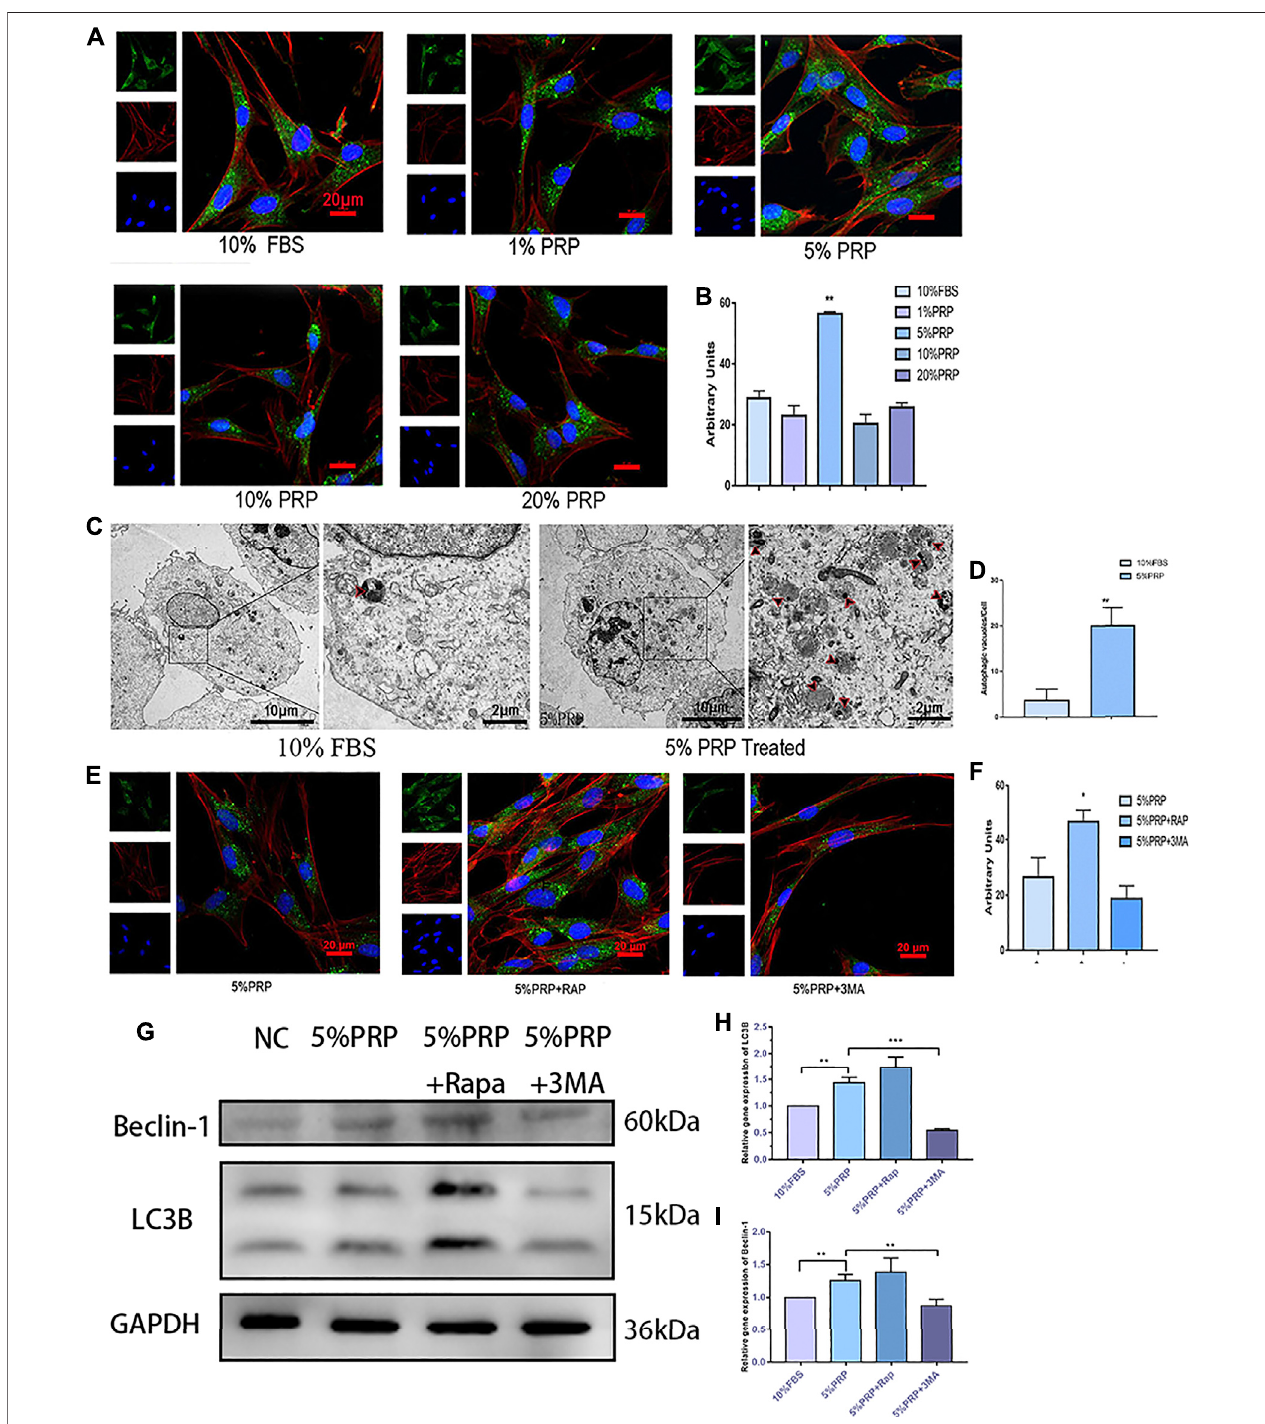
FIGURE 3 | (A) Autophagy activation by PRP. By immuno fl uorescence staining, 5% PRP obviously increased the expression of LC3B (scale bar, 20 μ m). (B) The graph shows the quantitative analysis of LC3B fl uorescence by Image J. (C) By transmission electron microscope, 5% PRP-treated hDPCs showed a large number of autophagic vacuoles. (D) The number of autophagic vacuoles per cell. Experiments were repeated three times. (E) Immuno fl uorescence staining of autophagy- associated protein was elevated byrapamycin, whereas itwas reduced by 3-MA (scale bar, 20 μ m). (F) Quantitative analysis ofLC3B fl uorescence was estimated by Image J. (G) Western blot analysis of the autophagy-associated proteins levels in the hDPCs treated with 5% PRP, rapamycin (RAP) (100 nM) + 5% PRP, or 3- methyladenine (3-MA) (5 mM) + 5% PRP for 24 h. (H) LC3B and Beclin-1 (I) mRNA expression were analyzed by quantitative PCR. Data in (B) , (C) , (D) , (F) , (H), and (I) are presented as mean ± standard deviation. Signi fi cantly different groups, * p < 0.05, ** p < 0.001.